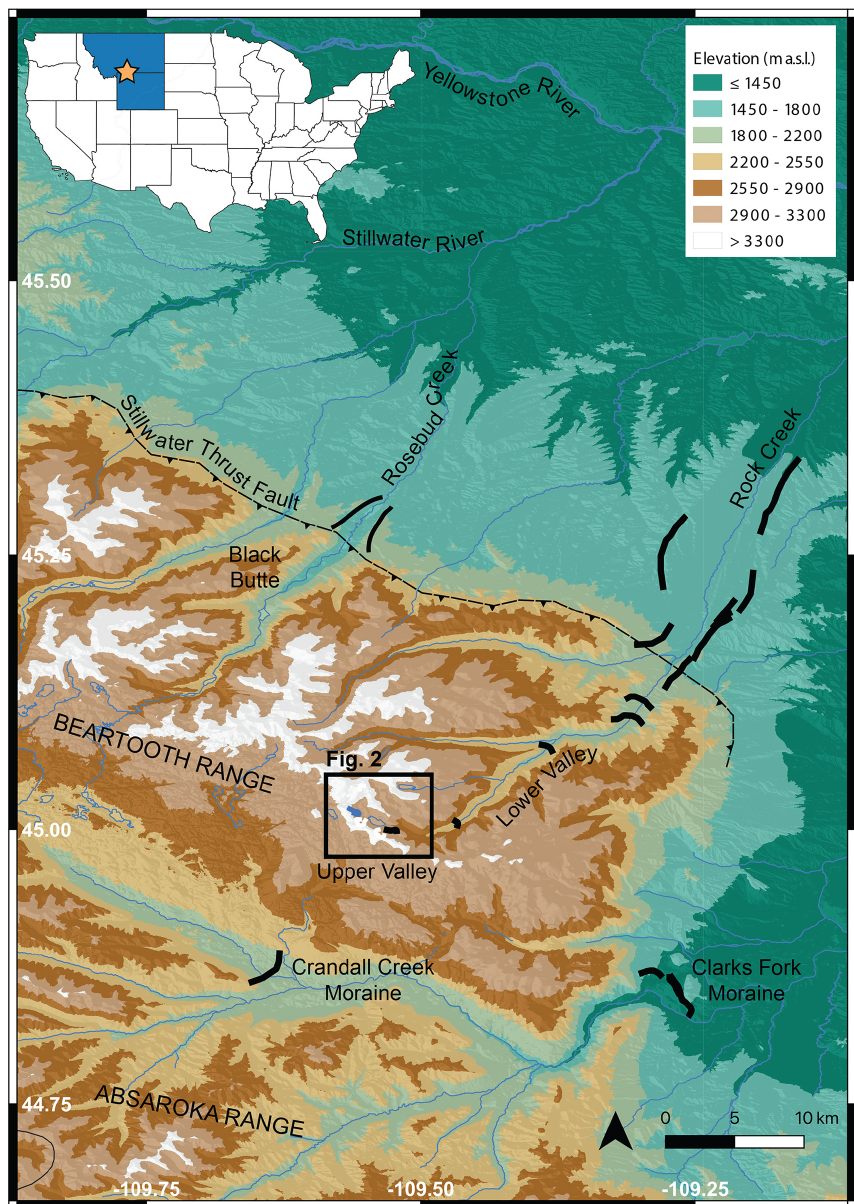
Figure 1. Regional map of the Beartooth Mountains in Montana and Wyoming, United States. Brown colors indicate higher elevation, and green colors indicate lower elevation. Solid black lines show the location of prominent moraines including those mapped by Graf (1971) in the Rock Creek drainage. The inset map shows the location of Montana (MT) and Wyoming (WY) highlighted in blue, with the approximate location of our study area indicated by the star. Elevation data from the U.S. Geological Survey 3D Elevation Program (U.S. Geological Survey, 20171130, USGS 13 arc-second n46w110 1 x 1 degree: U.S. Geological